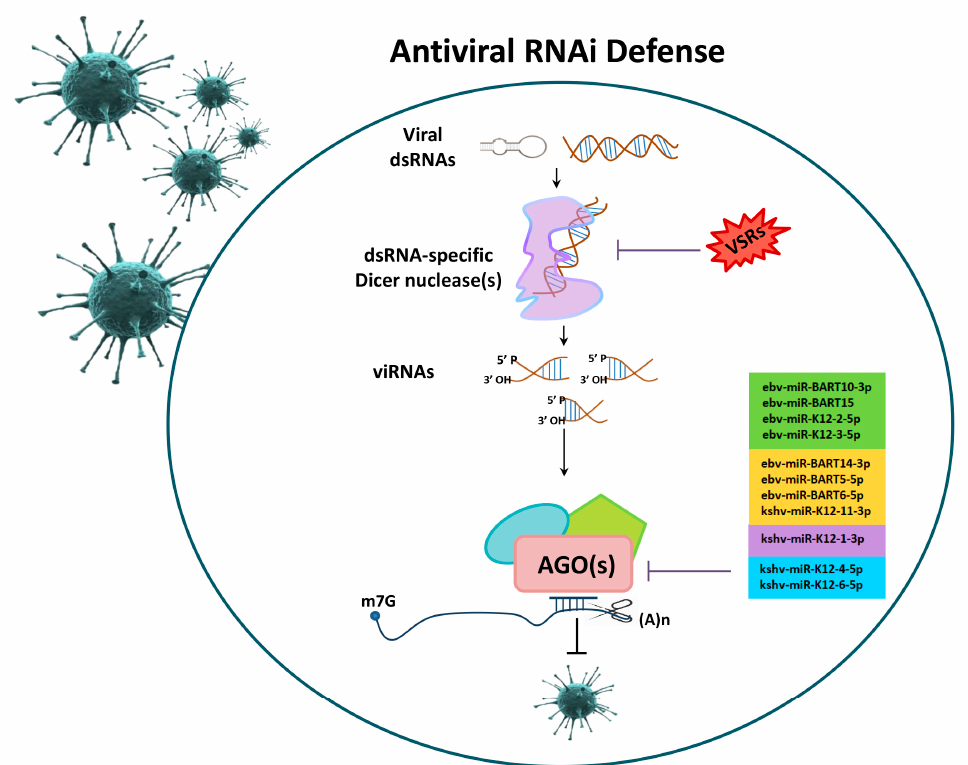
Figure 2. Post-transcriptional gene silencing during viral infections. Viruses that enter into eukaryotic hosts are able to produce their own miRNAs (viral miRNAs), which a ff ects the immune system or aids their latency phase by reducing their expression. Viral double-stranded RNAs are cleaved by the dsRNA-specific Dicer nuclease, which is a discrete family of PRRs, to generate virus-derived small RNAs (viRNAs) and, hence, RNAi-silencing activation. To counterbalance viRNAs production, viruses express intrinsic Viral Suppressors of RNA silencing (VSRs) factors in order to protect themselves from Dicer-mediated cleavage and / or impede viRNAs loading onto AGO proteins. Based on the analysis of published datasets [82–84], human Ago-gene expression can be regulated by viRNAs derived from EBV and Kaposi’s Sarcoma-associated Herpes virus